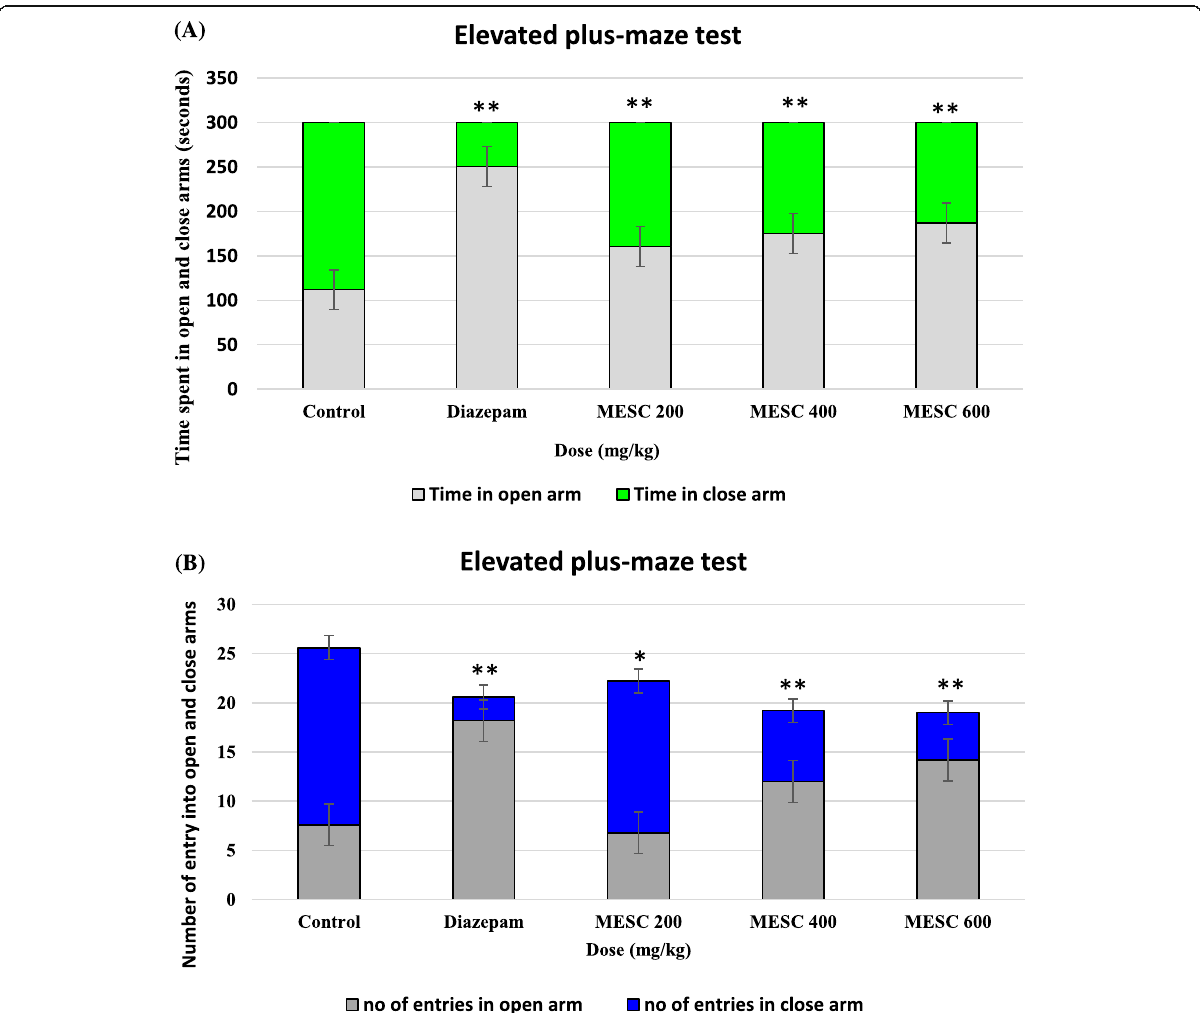
Fig. 3 The anxiolytic effect of MESC on elevated plus-maze test in mice. a Time spent in open and close arms; b Number of entry into open and close arms. i. * p < 0.001 vs control group. ii.** p < 0.0001 vs control group. [Control (NaCl saline 0.1 ml/ mouse), Diazepam (1 mg/kg B.W.), MESC (200, 400 and 600 mg/kg B.W)]